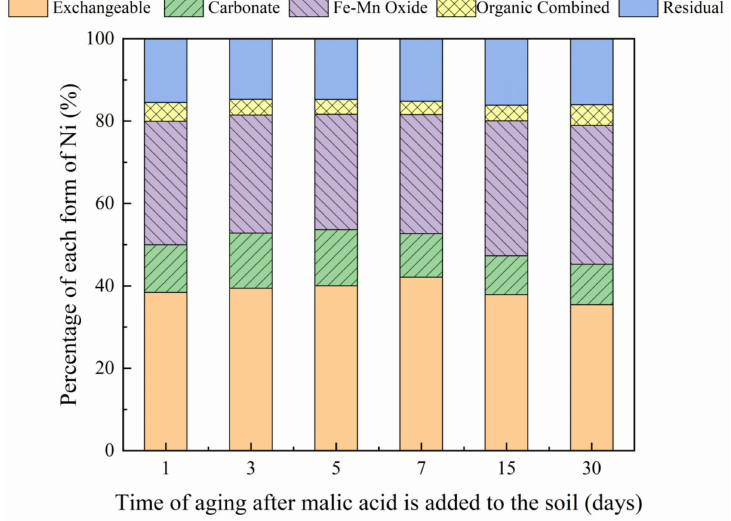
Figure 13. Distribution of different Ni forms at different aging times (1, 3, 5, 7, 15, and 30 days) after the addition of malic acid to Ni-300 mg/kg contaminated